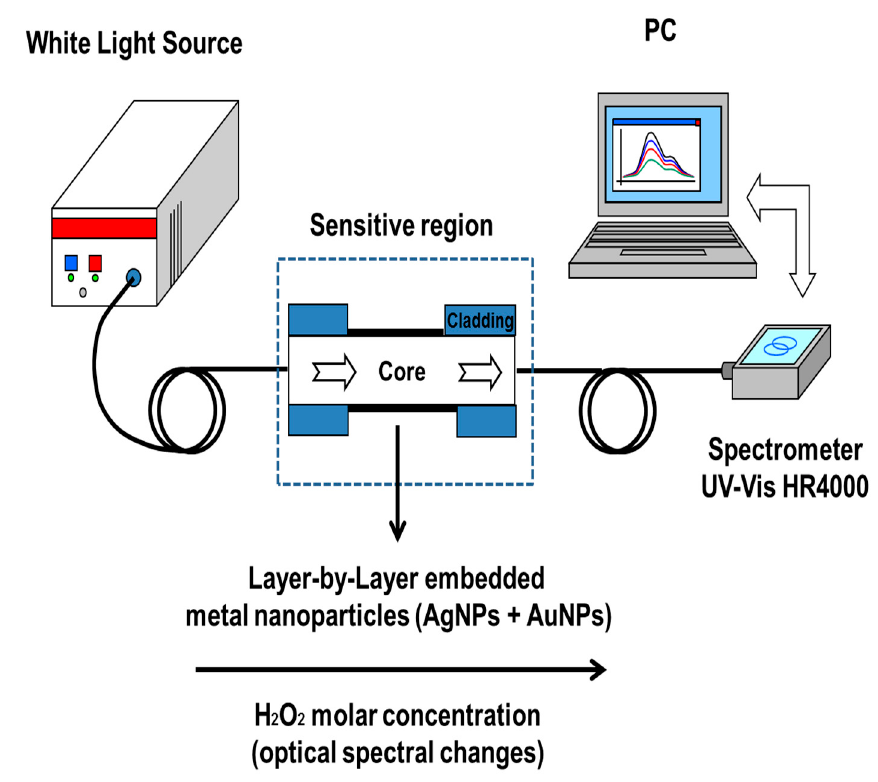
Figure 1. Schematic representation of the experimental setup for hydrogen peroxide detection as a function of the optical spectral changes associated to the metallic nanoparticles incorporated in the Layer-by-Layer coatings.